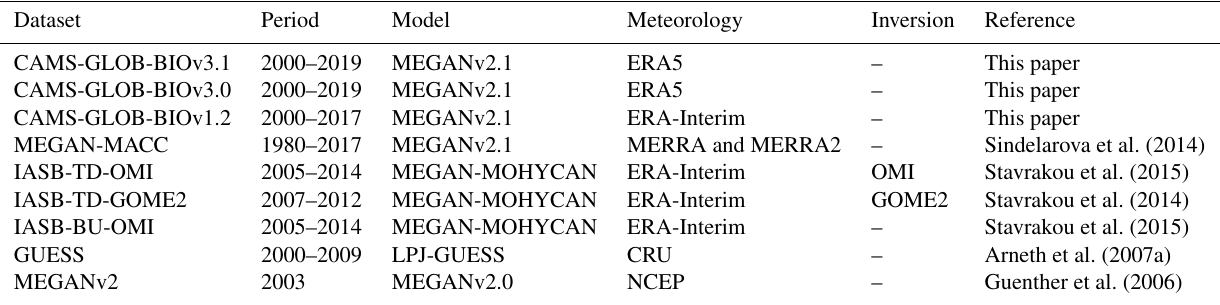
Table 7. List of datasets used for comparison of emissions.